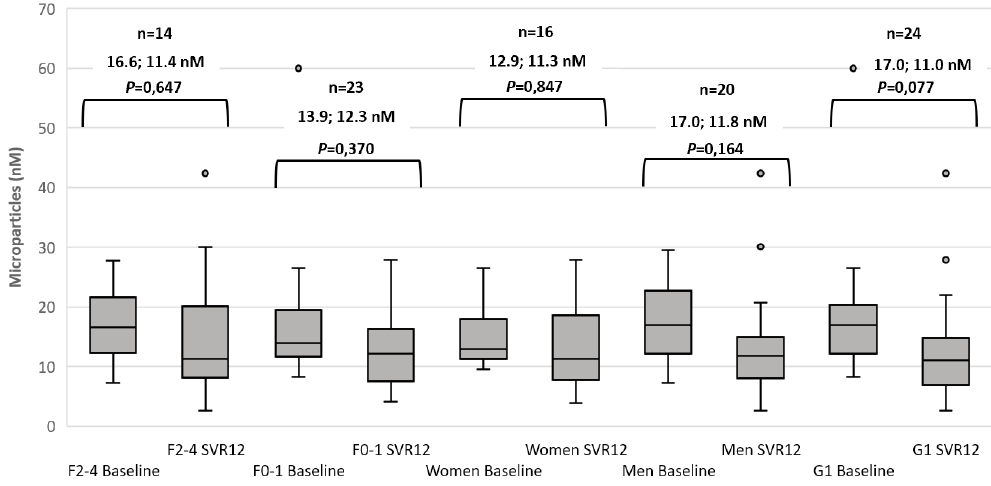
Fig. 2. Microparticles levels at baseline and SVR12 in studied subpopulations.